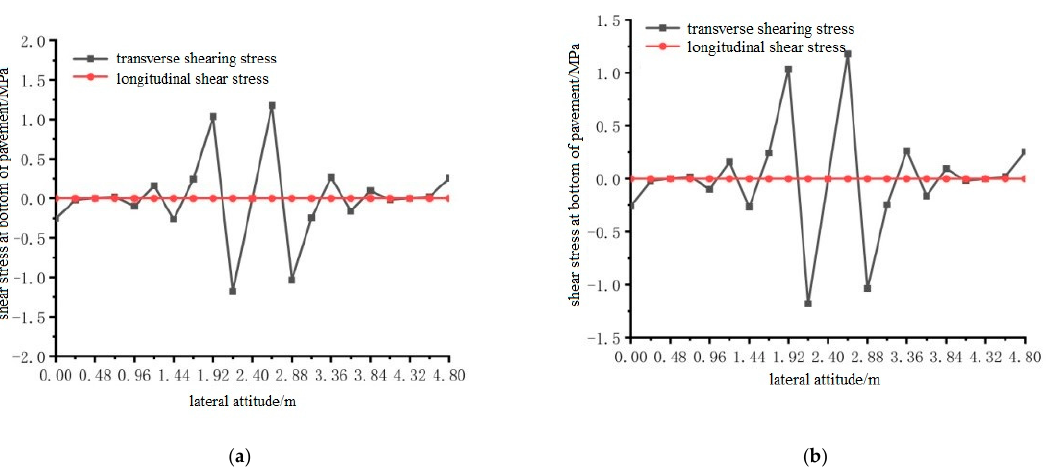
Figure 30. The transverse distribution of longitudinal and transverse shear stress on the bottom surface of the pavement with and without temperature field under the action of load level 1. ( a ) Longitudinal and transverse shear stress diagrams without temperature field; ( b ) Longitudinal and transverse shear stress diagrams with temperature field effect.